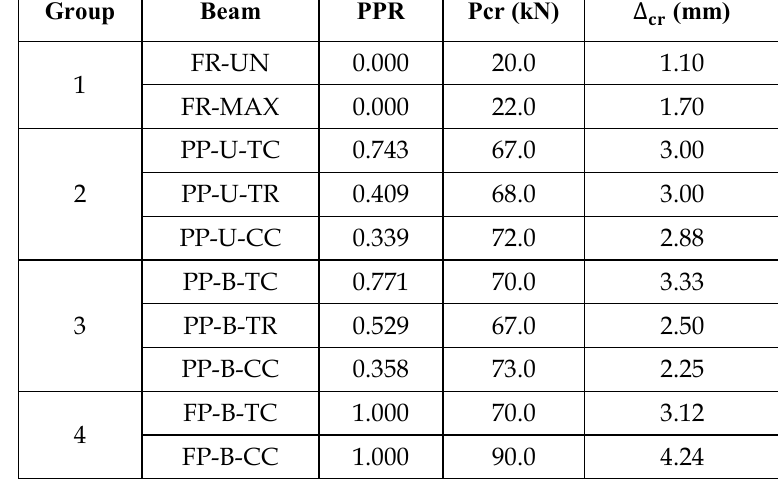
Table 5 Experimental results for beams tested by Oukaili and Khattab (10). Group Beam PPR Pcr (kN)